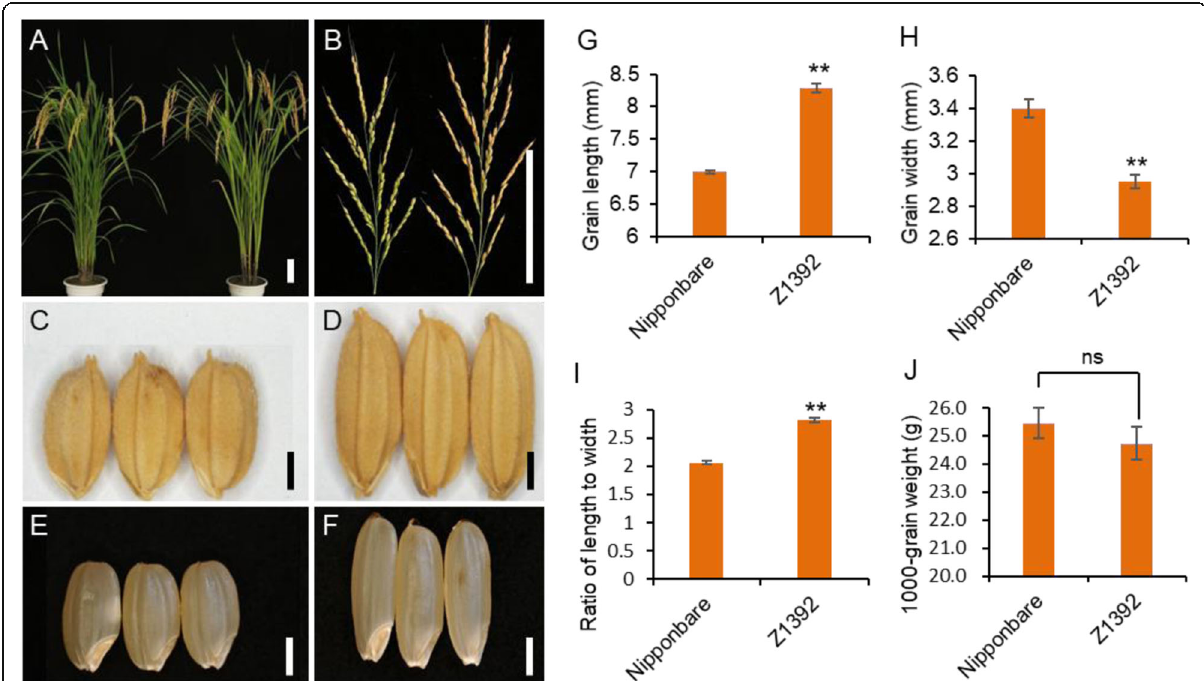
Fig. 2 Phenotype of Nipponbare and Z1392. a , Plant type of Nipponbare (left) and Z1392 (right). b , Main panicle of Nipponbare (left) and Z1392 (right). c , d , Grains of Nipponbare ( c ) and Z1392 ( d ). e , f , Brown grains of Nipponbare ( e ) and Z1392 ( f ). g - j , Grain length ( g ), grain width ( h ), ratia of length to width( i ) and 1000-grain weigth( j ) of Nipponbare and Z1392. Bars in A and B, 10 cm; C – F, 2